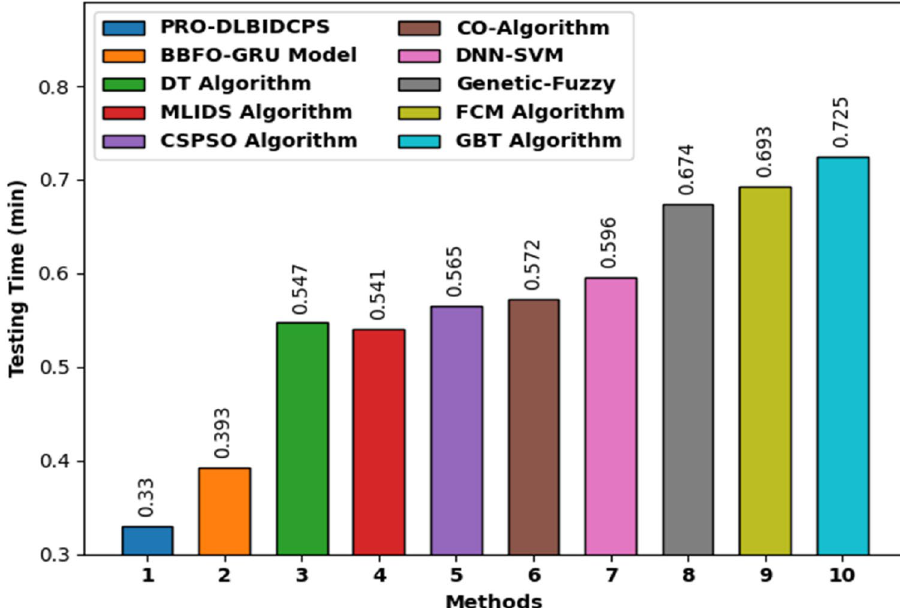
Figure 14. Comparative TST analysis of the PRO-DLBIDCPS